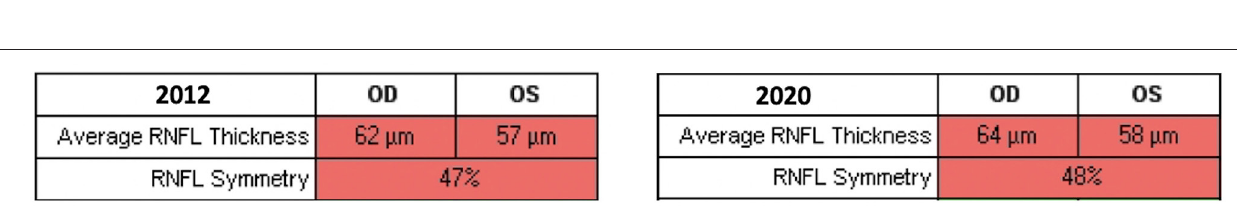
at each control. Pupils were isochoric, normoreactive to light and no relative afferent pupillary defect was